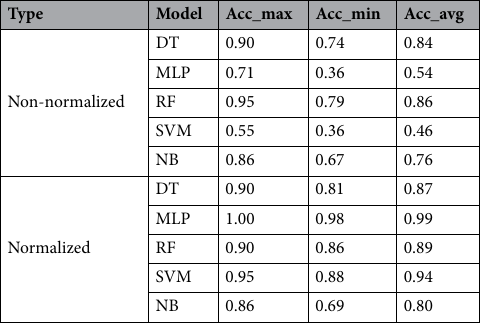
Table 3. Classification model results based on full spectrum data.